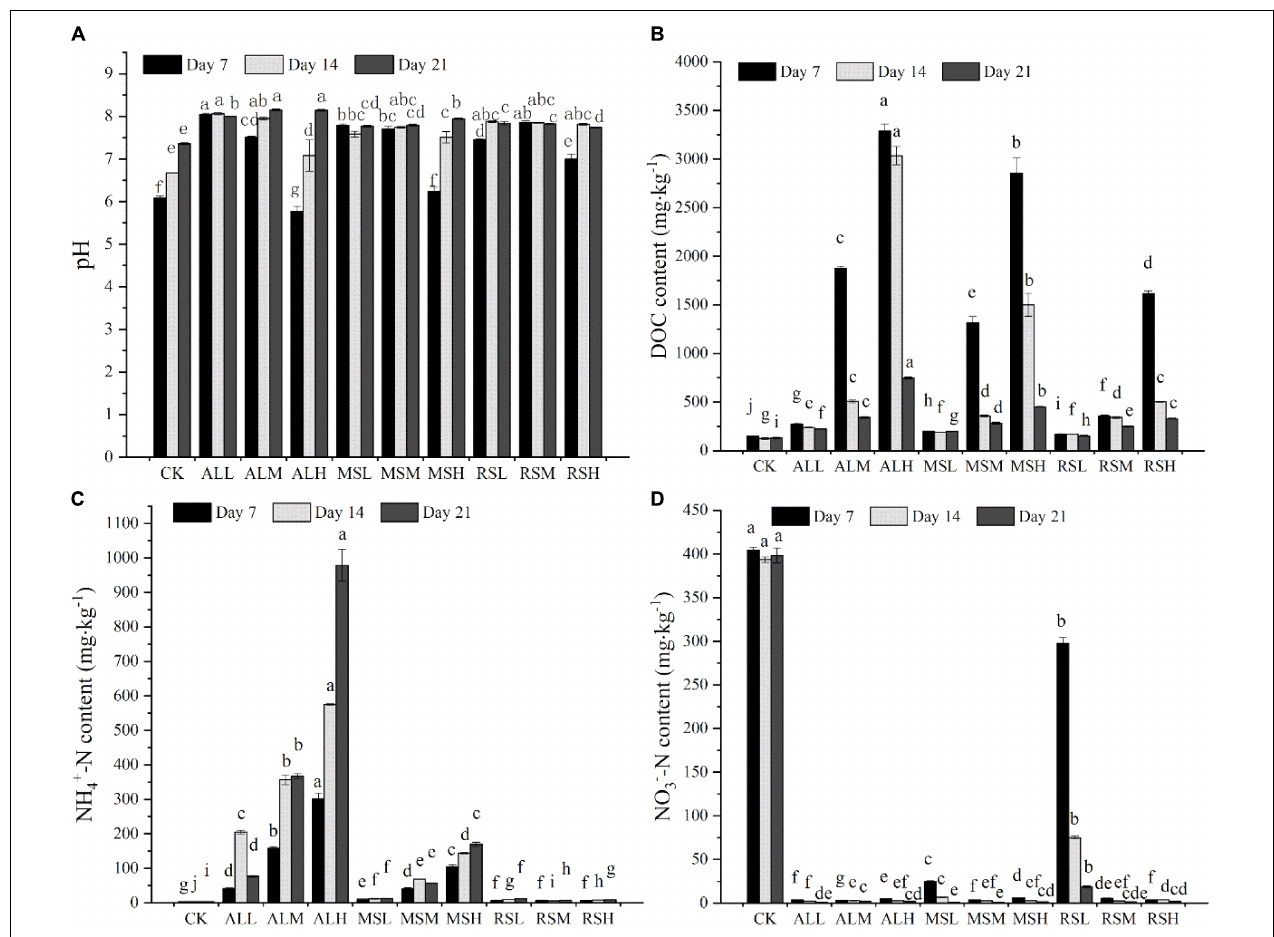
FIGURE 1 | The soil pH (A) , DOC content (B) , ammonia nitrogen content (C) , and nitrate nitrogen content (D) during RSD. Bars with different letters represent significant differences among the 10 treatments at the same time, as determined using Duncan’s tests ( P < 0.05). Error bars indicate standard